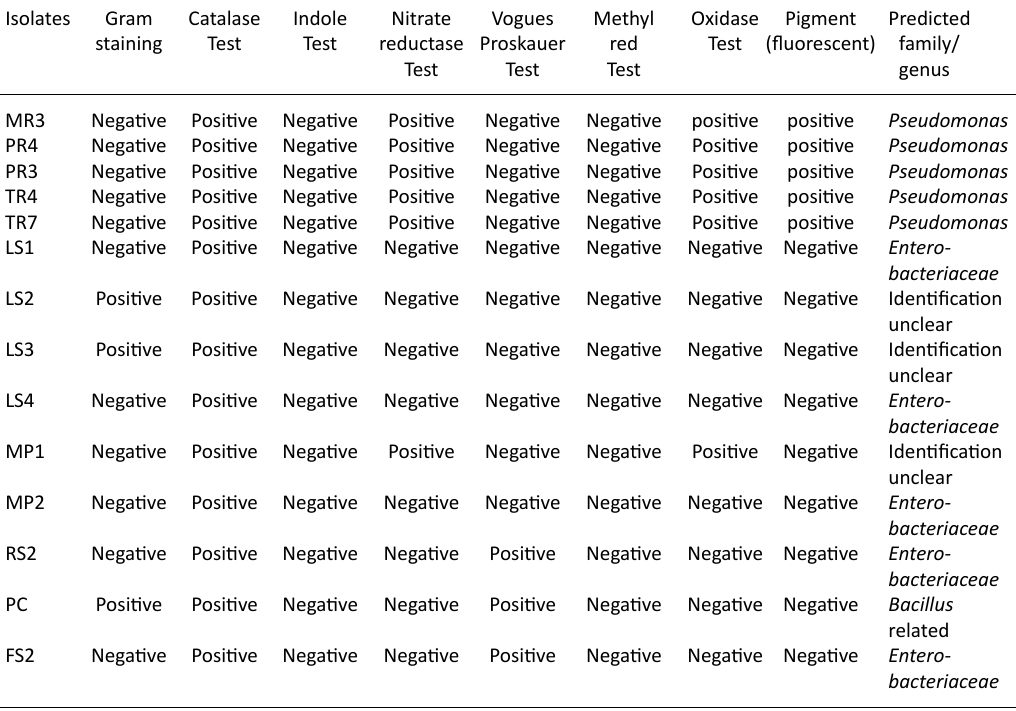
Table 2. Microscopic and biochemical characterization of selected isolates